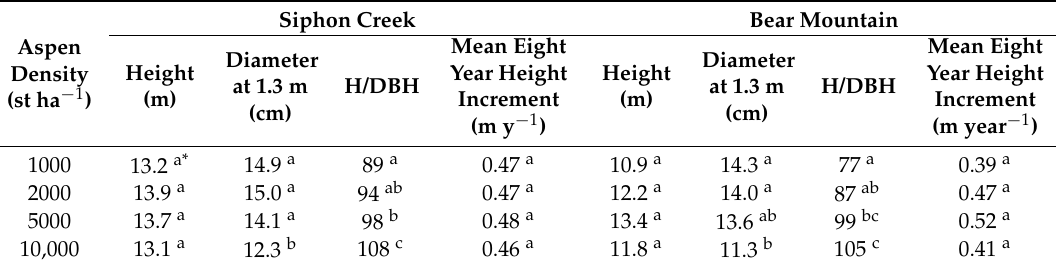
Table 4. Mean aspen height, diameter, height/diameter and eight year height increment (2002 measurement to 2010 measurement) at Siphon Creek (25 years old) and Bear Mountain (22 years old) for the four largest diameter aspen in each